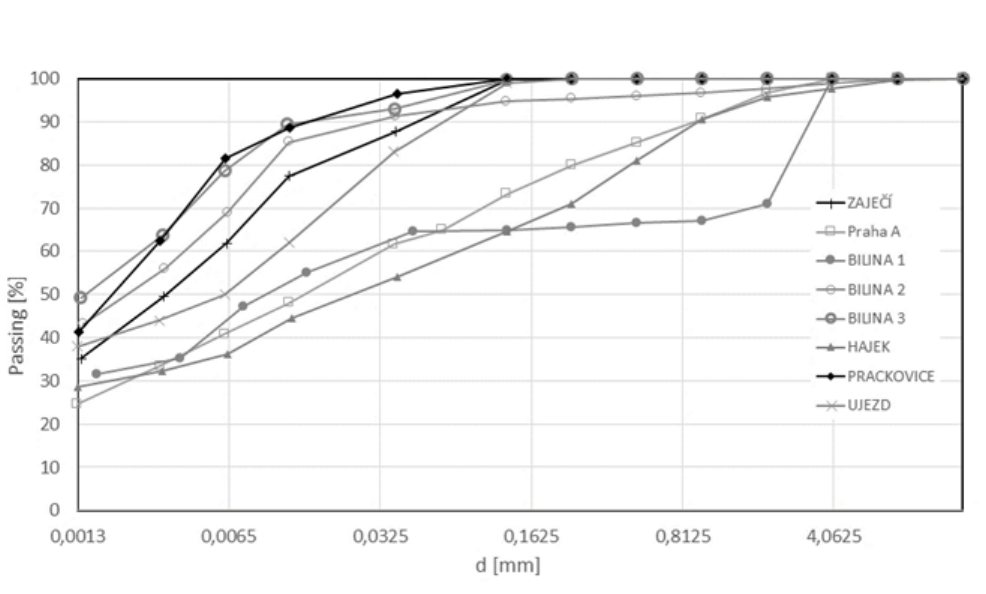
Figure 4. Particle-size distribution for eight samples of sampled